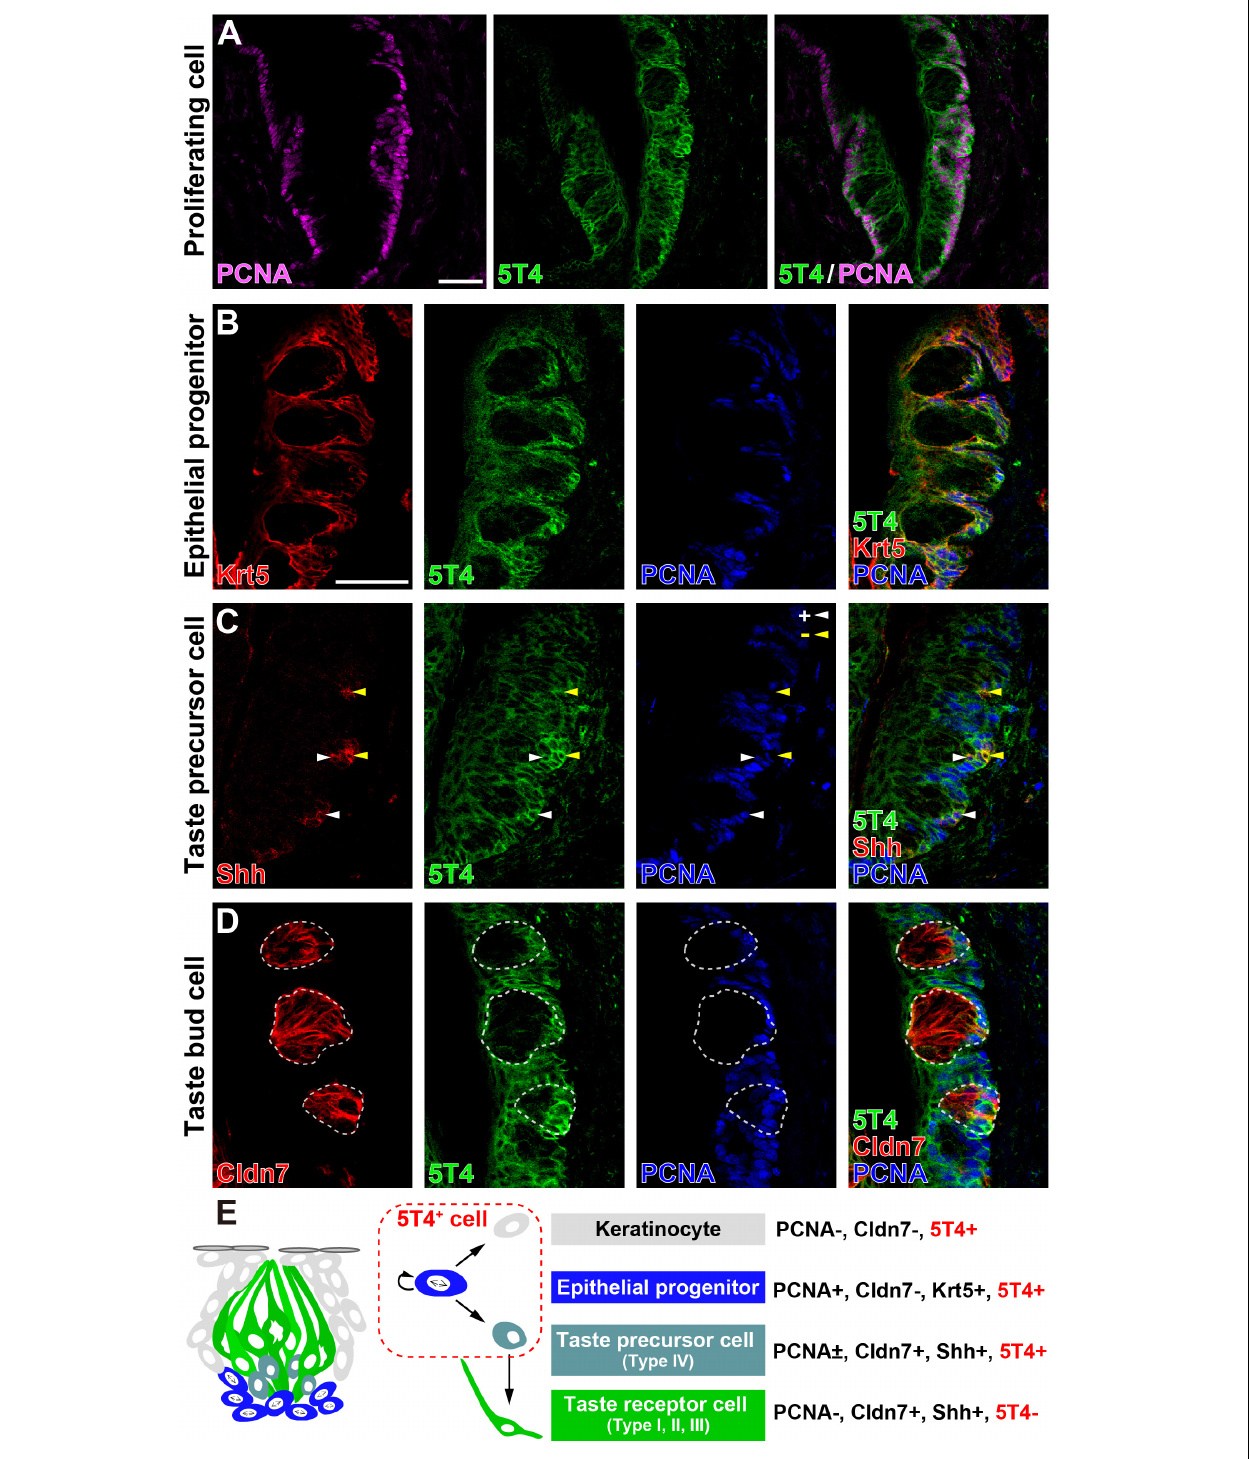
FIGURE 2 | 5T4 is highly expressed in proliferating cells in the basal part of the CVP. (A) IHC of the CVP using antibodies against 5T4 (green) and PCNA (a marker of proliferating cells; magenta). Scale bars, 50 µ m. (B–D) IHC of the CVP using antibodies against 5T4 (green) and PCNA (a marker of proliferating cells; blue) in addition to antibodies (red) against various cell type markers, including Krt5 (a marker of epithelial progenitors; B ), Shh (a marker of taste precursor cells; C ), and Cldn7 (a marker of TBCs; D ). PCNA + and PCNA - cells among Shh + taste precursor cells are indicated by white and yellow arrowheads, respectively (C) . Scale bars, 50 µ m. Each white dotted line indicates the Cldn7 + area as a taste bud. All images are single confocal optical sections (0.56 µ m/slice). (E) A schematic drawing of the mouse taste bud as modified from Barlow (2015), summarizing the results of IHC analysis of epithelial progenitors, taste precursor cells, and taste receptor cells.